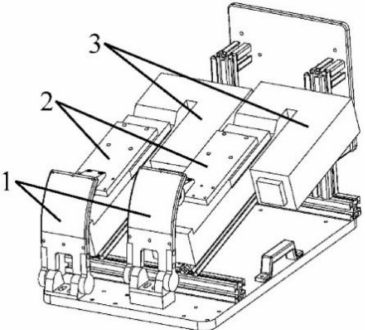
Figure 2. The axonometric drawing of pedal robot designed in this work. The numbers denote the following: 1—end-effectors of the robot, 2—sliders, and 3—servo motors.